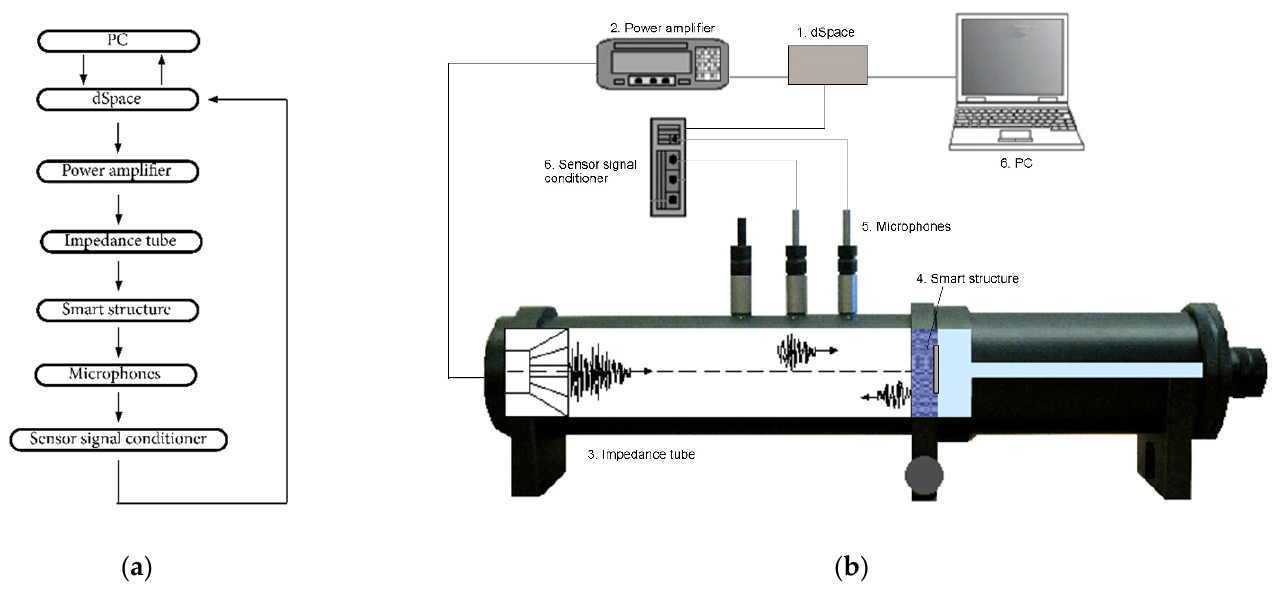
Figure 10. Setup for tests in the active case: ( a ) scheme and ( b ) instrumentation. The dSpace generates two outputs. The first one, connected to the loudspeaker, is a sine wave with amplitude 0.05 and a frequency that can be modified from the ControlDesk application. The second one, connected to the HX amplifier and to the patch, is the control law signal. For inputs, the dSpace receives the sound pressures at the three microphone positions of the tube. The three pressures are exploited to obtain the reflection and incident pressure wave amplitude through the transfer function method. The reflected pressure wave component in the frequency domain is evaluated by